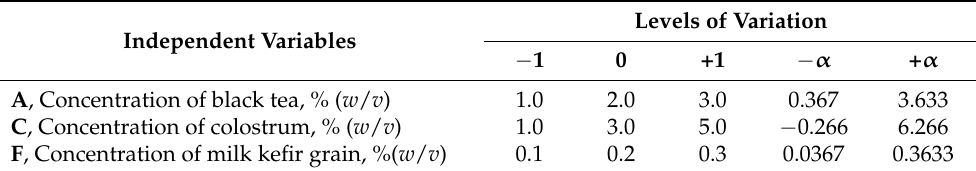
Table 2. Independent variables and their levels of variation in the CCD for RSM. Levels of Variation Independent Variables − 1 0 +1 − α + α A , Concentration of black tea, % ( w / v ) C , Concentration of colostrum, % ( w / v